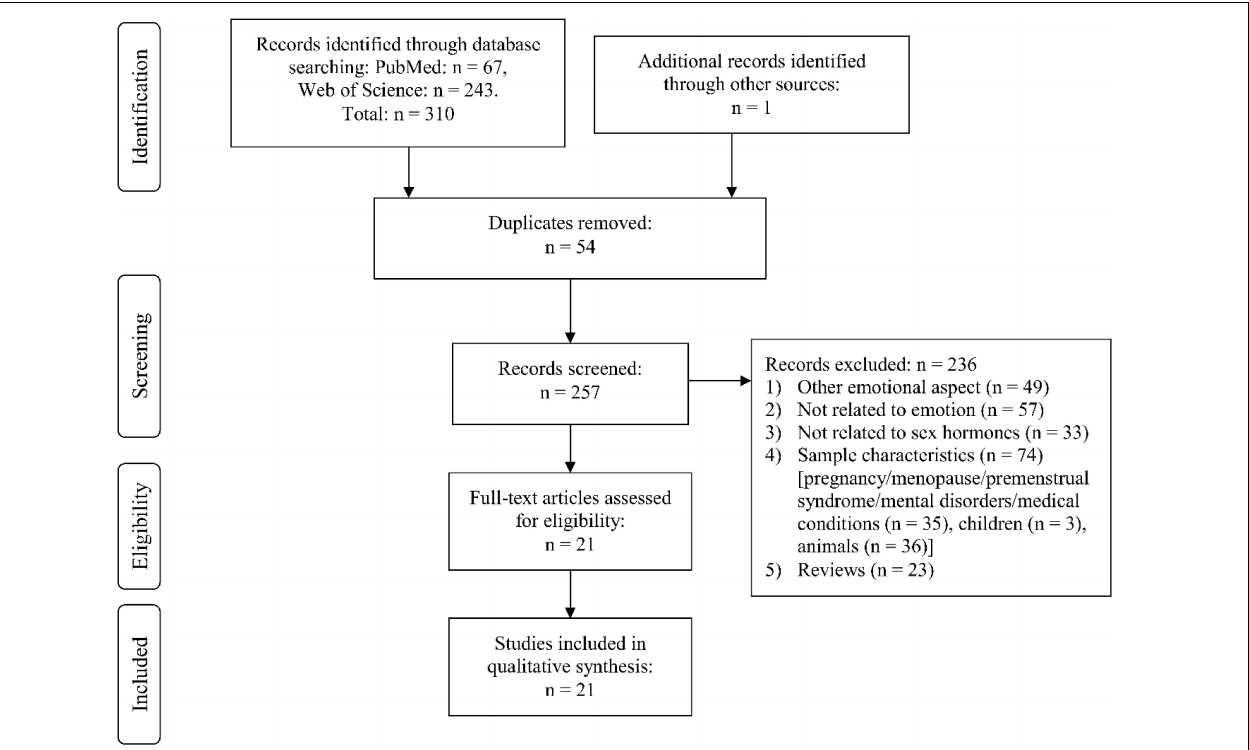
FIGURE 2 | Flow chart showing detailed systematic search and selection process for emotional